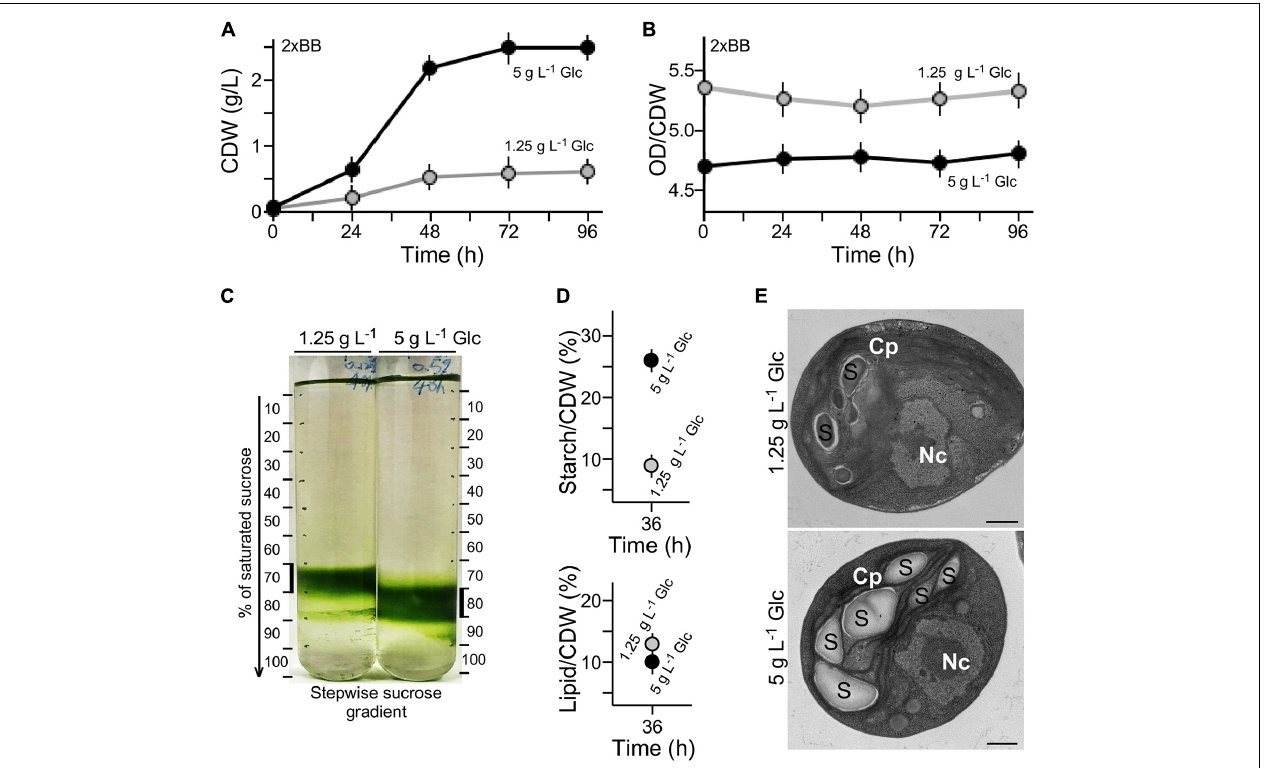
FIGURE 2 | High cell density is associated with high-level accumulation of starch in medium with high glucose supplementation. (A) Growth curves expressed in CDW. (B) Conversion rate between OD value and CDW of cultures with high glucose and low glucose supplementation. (C) Sucrose gradient centrifugation analysis of cell density in medium with high glucose and low glucose supplementation. (D) Starch and lipid contents of G32 cells with high glucose and low glucose supplementation. (E) Transmission electron microscopic analysis. Nc and Cp stand for nucleus and chloroplast, S for starch granule. Scale bar of 500 nm is